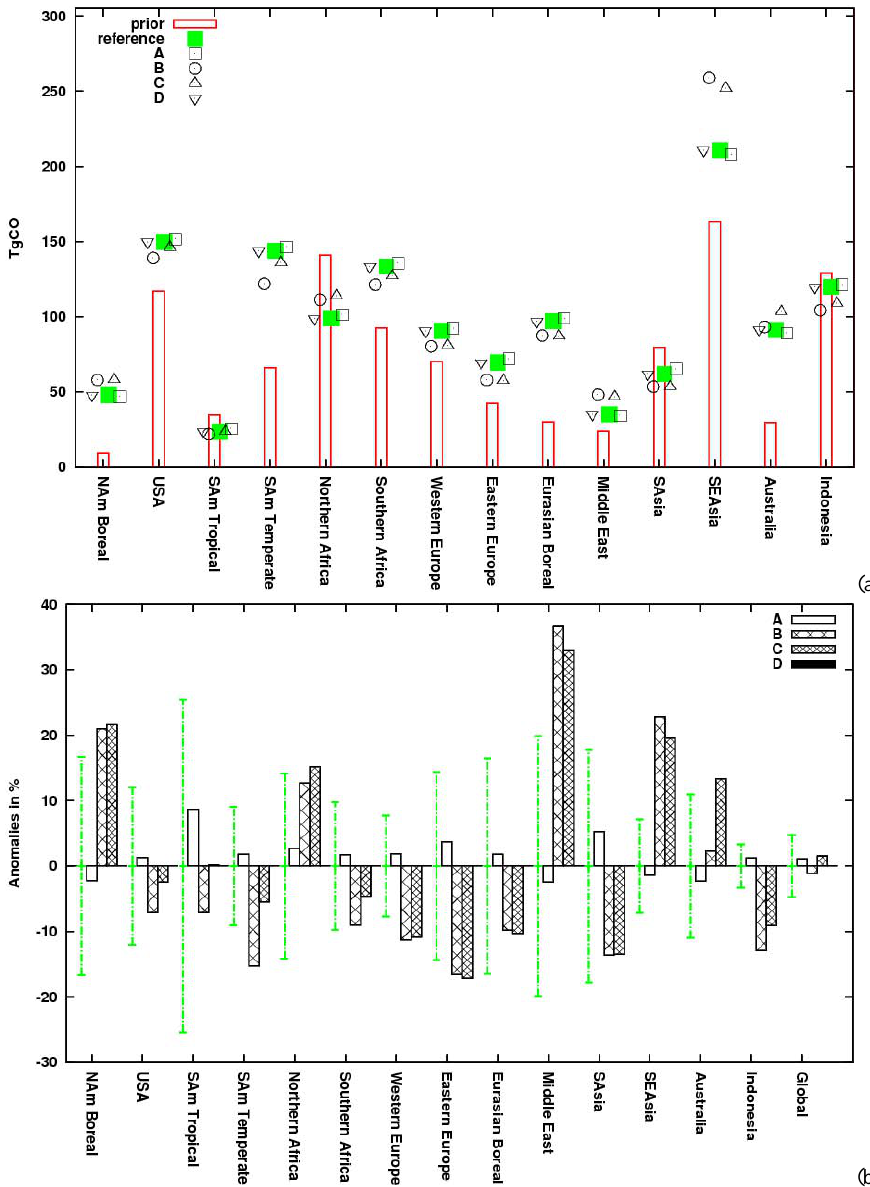
Fig. 11. Same as Fig. 10, but for CO